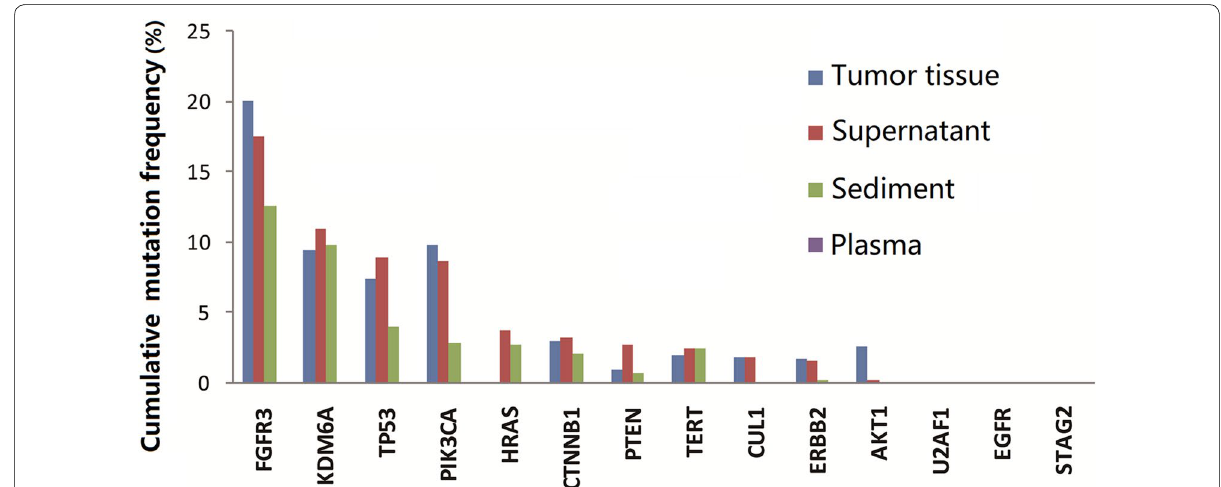
Fig. 2 Average mutation frequencies in 14 bladder cancer biomarker genes in 16 cases in the pilot study. The cumulative frequencies of mutations identified in urine supernatant and urine sediments were comparable with those in tumor tissue and significantly higher than those in plasma